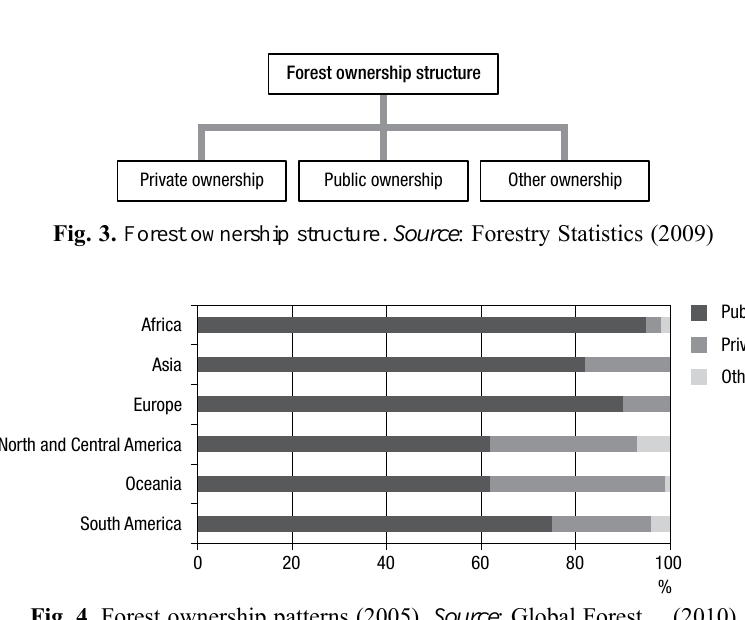
Fig. 4. Forest ownership patterns (2005). Source : Global Forest…